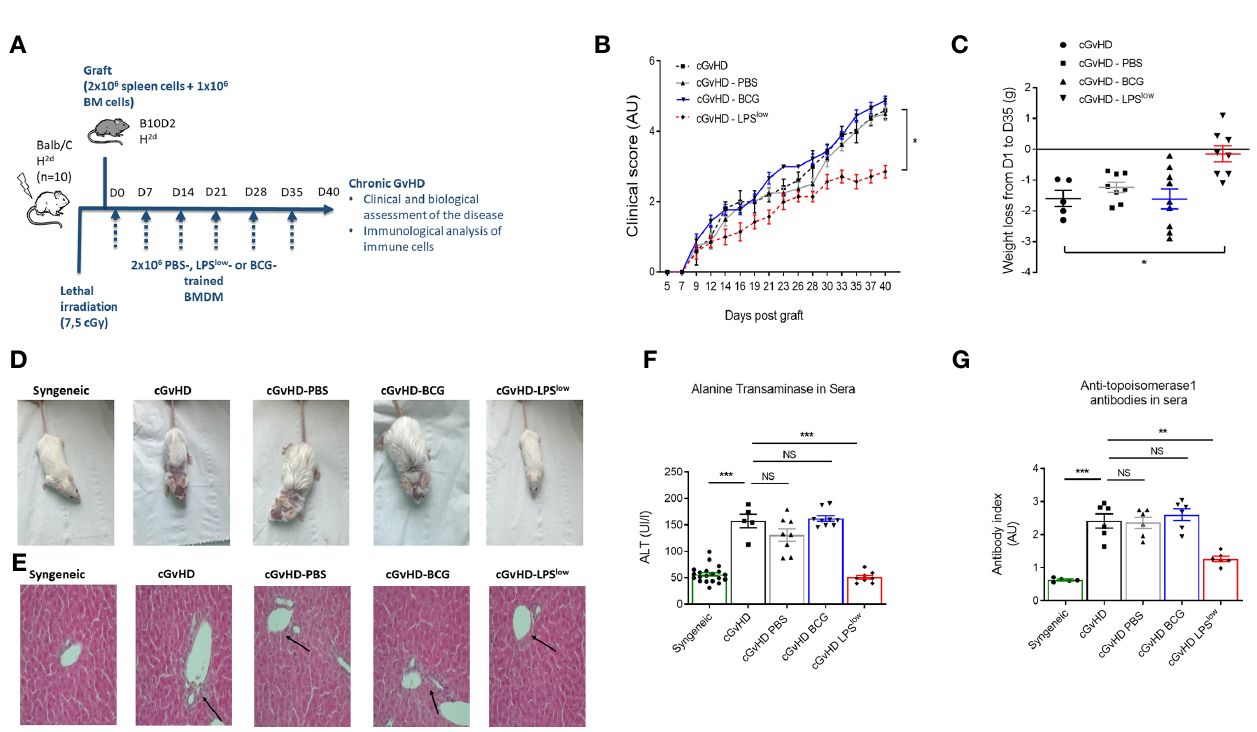
FIGURE 2 | Adoptive transfer of trained macrophages modulates cGvHD in mice. (A) Schematic representation of the experimental induction of sclerodermatous chronic graft- versus -host disease in mice and scheduling of trained macrophages infusion. Mice (n = 7 at least per group) were monitored for survival, weight, clinical signs of chronic GvHD for 40 days in one experiment. (B) Clinical score assessment of the different groups of cGvHD mice. The scoring system included fi ve clinical criteria (maximum index of 5) representing the sum of the recorded values and expressed in arbitrary unit (AU). (C) Weight loss assessment of the different groups of cGvHD mice. Mice were weighted at day 0 of the experiment and equitably distributed into the different groups according to their initial weight. At day of the sacri fi ce, each identi fi ed mouse was weighted to determine the weight loss delta. Scatter plots represent individual data with mean ± SEM obtained from at least n = 5 biologically independent mice: syngeneic (n = 5); cGvHD (n =5); cGvHD-PBS (n = 8); cGvHD-BCG (n = 9); cGvHD-LPS low (n = 8). Statistical differences between the groups were detected by the ANOVA test with Bonferroni correction. (D) Representative photographs of mice at day 40 after BMT showing hair aspect (spiky coat and alopecia in the cGvHD animals compared to the syngeneic group). (E) Representative liver section of 5 m m stained with hematoxylin and eosin showing increased periportal mononuclear cell in fi ltration in cGhVD mice compared to syngeneic group. Photographs were taken with a Nikon Eclipse 80i microscope. Original magni fi cation ×40. (F) Levels of serum alanine aminotransferase (ALT) in the different experimental groups. Each box represents the mean of the concentration expressed in international unit per liter ± SEM. (G) Anti-topoisomerase 1 antibody levels in the different experimental groups measured by ELISA. Each box represents the mean of the antibody index expressed in arbitrary unit ± SEM. The ANOVA test with Bonferroni correction was used to detect signi fi cant differences between the groups (unless stated). NS, non-signi fi cant; *p ≤ 0.05; **p ≤ 0.01; ***p ≤